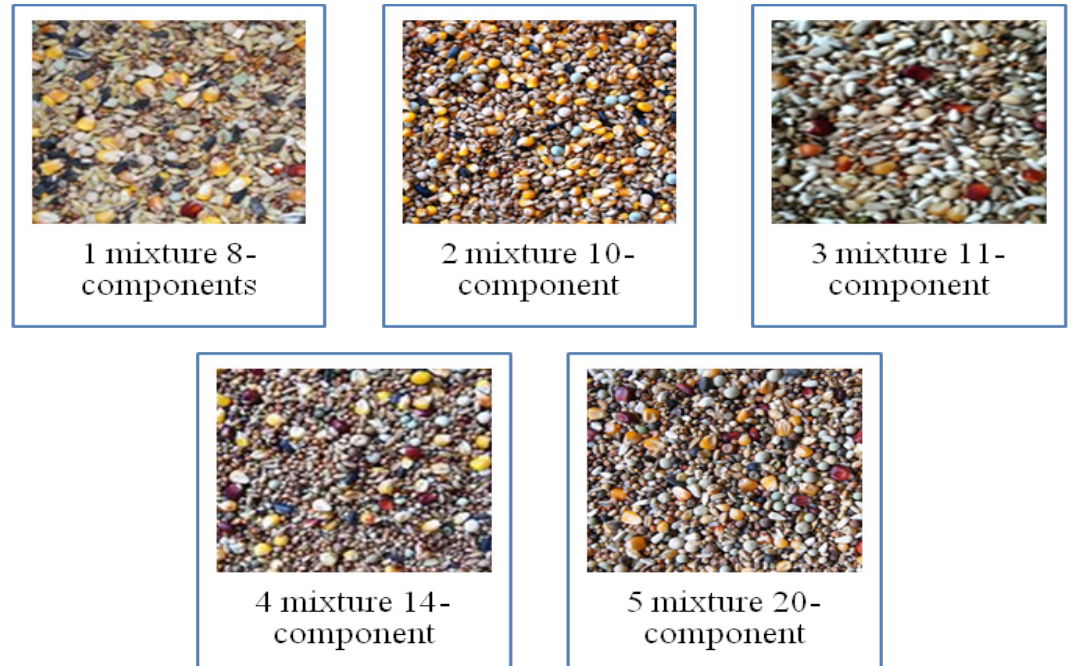
Figure 1: Feed mixtures used in